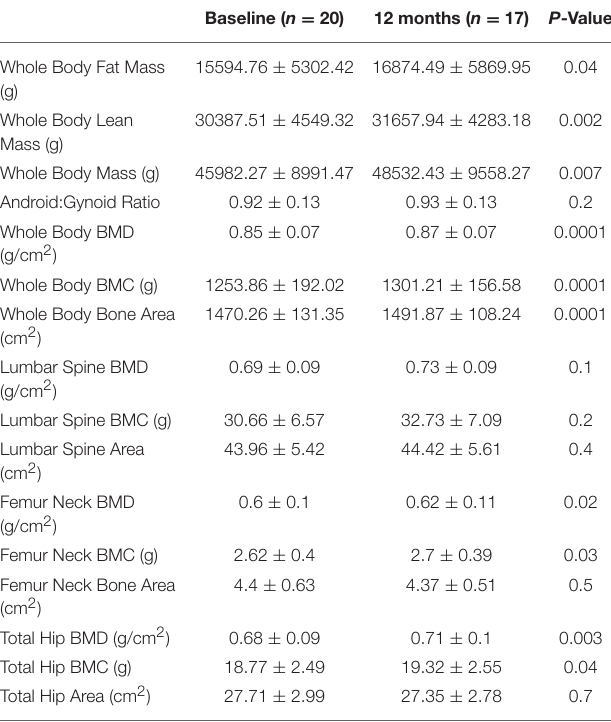
TABLE 3 | Bone mineral status and body composition baseline and after 12 months